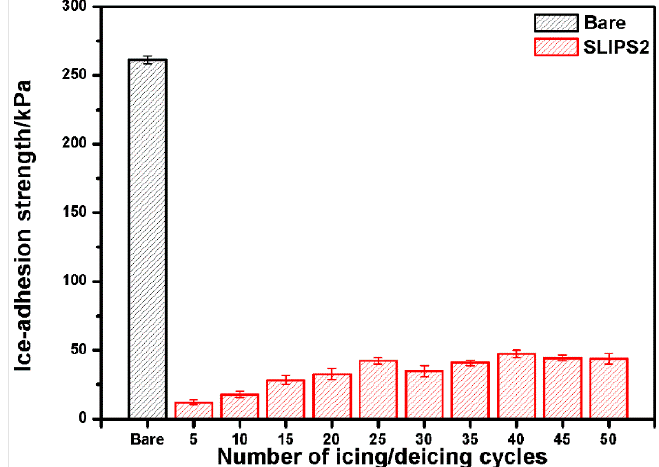
Figure 7. Variation of ice-adhesion strength of SLIPS2 after a number of icing/deicing cycles.